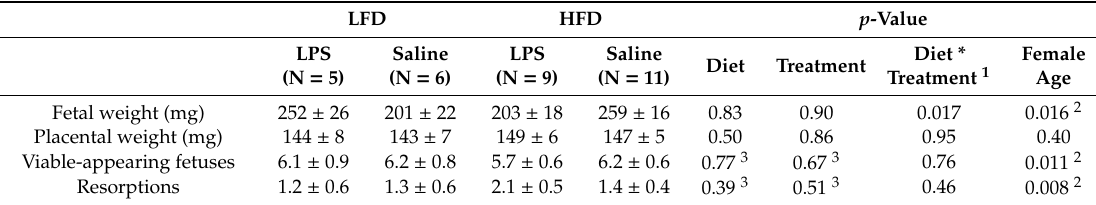
Table 4. Reproductive traits in females fed a high-fat diet (HFD) or low-fat diet (LFD) for 13 weeks prior to mating, injected with LPS or saline on gestational day 7 and found to be pregnant at gestational day